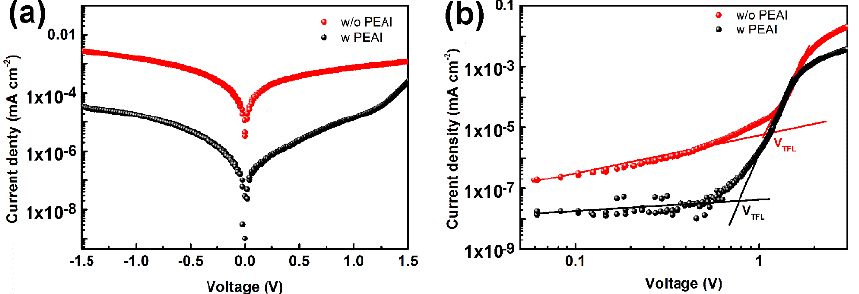
Figure 5. ( a ) Dark J-V and ( b ) SCLC versus voltage curves of undoped and PEAI-doped devices ( V TFL are obtained to be 1.061 and 0.776 V for the undoped and PEAI-doped devices, respectively). A series of CsPbBr 3 PSCs are fabricated with an architecture of FTO/compct-TiO 2 / mesoporous-TiO 2 /CsPbBr 3 /carbon. The active area is 0.1 cm 2 , and the whole preparation process of the PSCs was finished in ambient air. The dependences of photovoltaic perfor- mances on PEAI concentrations are reflected by Figure S2 in the Supplementary Materials, and the corresponding photovoltaic parameters are summarized in the inset of Figure S2, which shows that the optimal doping concentration of PEAI is 10 mg/mL, consistent with the XRD and SEM characterization